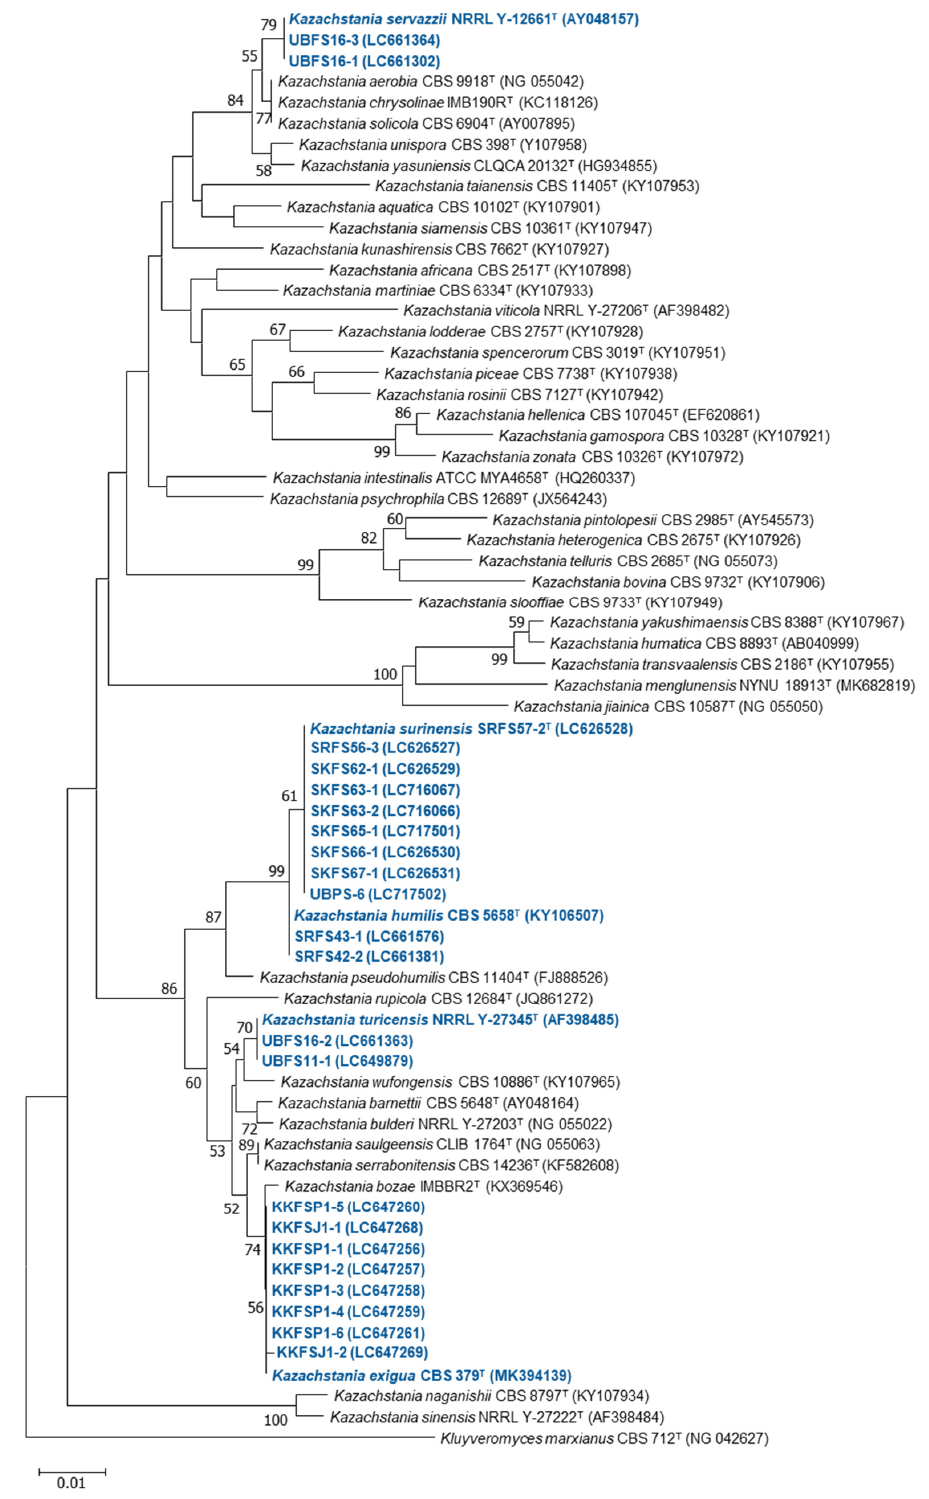
Figure 5. A neighbor-joining phylogenetic tree of Kazachstania yeasts isolated from Plaa-som samples in this study (blue) and all other recognized Kazachstania species (black) based on the D1/D2 region of the LSU rRNA sequence data set. The bootstep values are calculated using 1000 re-samplings for indicating the nodes. It should be noted that strains SKF62-1, SKF66-1, SKF67-1, SRF56-3, and SRF57-2 were described as Kazachstania surinensis [43]. Strains SKF63-1, SKF63-2, SKF65-1, and UBPS-6 were also identified as Kazachstania surinensis